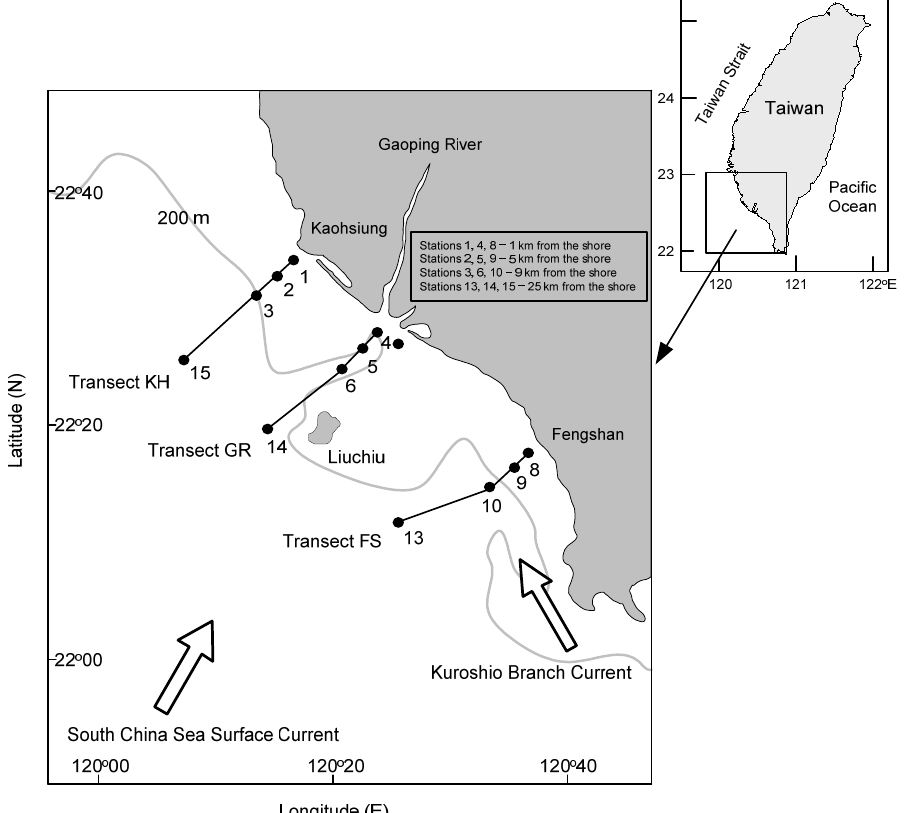
Figure 1. Map of the study area and sampling stations in the Gaoping waters of southwestern Taiwan. KH: Kaohsiung Harbor; GR: Gaoping River estuary; FS: Fengshan Township.